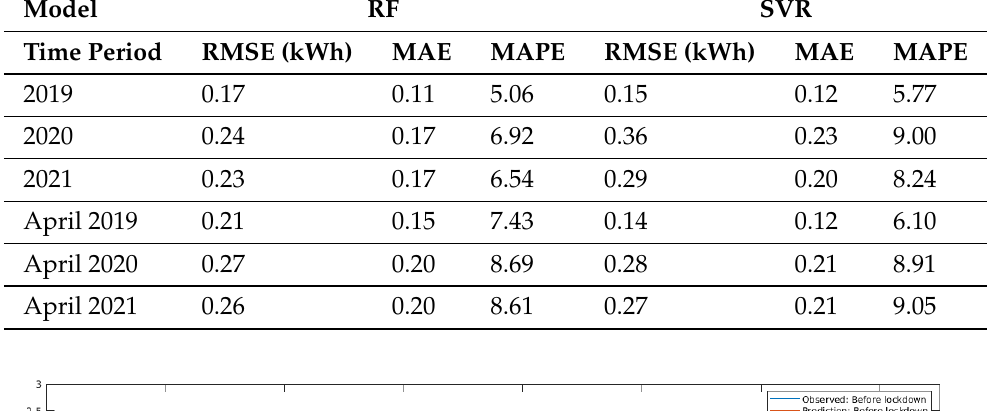
Table 2. Day-ahead prediction performance comparison for the AC-included category. Model